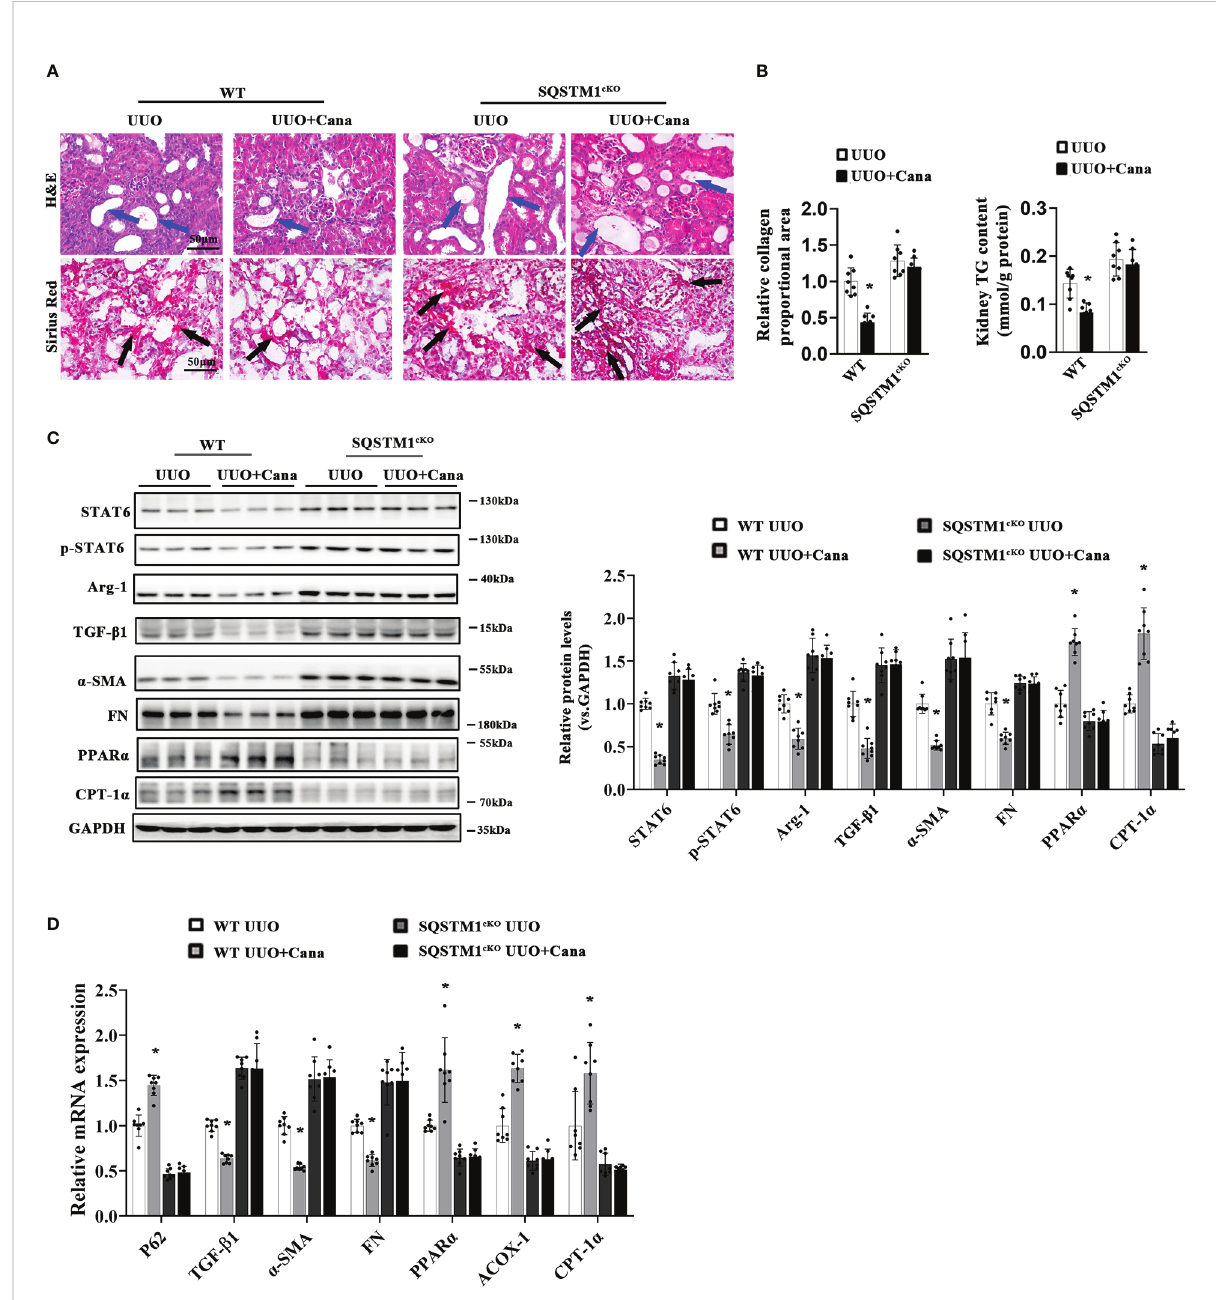
FIGURE 7 SQSTM1 deletion eliminated the protection effect of Cana against tubulointerstitial fi brosis. (A) Representative micrographs for H&E and Sirius Red staining of kidney sections from the indicated groups of mice. Quanti fi cation of the relative collagen proportional area from each group of mice was performed. (B) TG content was determined in the kidneys from each group of mice. (C) Immunoblot analyses in the kidneys from each indicated group with quanti fi cation. (D) The mRNA levels were measured by qPCR assay in the kidneys from each indicated group. Results are expressed as mean ± SD (n = 8 * p < 0.05, UUO vs . UUO+